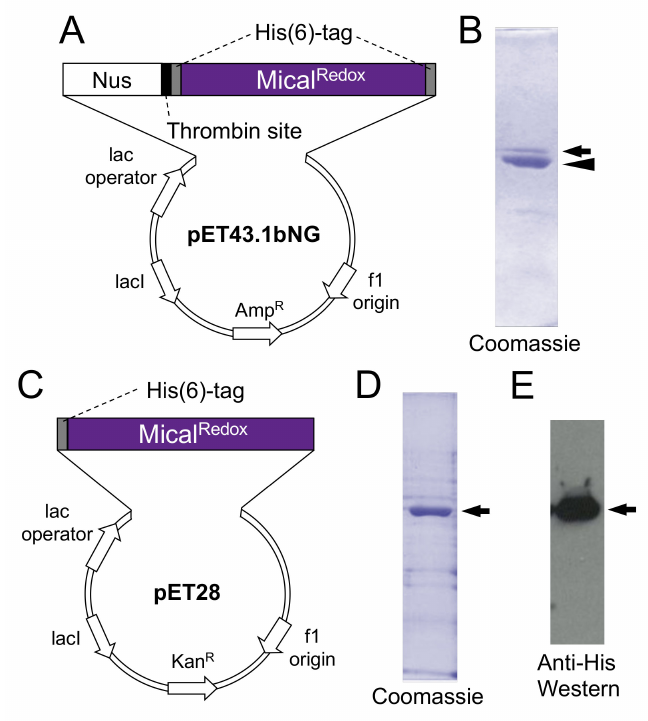
Figure 2. Expression and purification of Mical Redox protein with different fusion partners and chaperonins. ( A , B ) Nus solubility tag and low-temperature chaperonins only allow expression and solubility of small amounts of the Redox only portion of Mical. ( A ) Vector (pET43.1bNG) and insert for expressing a Nus solubility tag fused to Mical Redox protein. ( B ) Following thrombin digestion to remove the Nus solubility tag, the expected 1:1 ratio of Nus:Mical Redox protein is affected. In particular, while the Nus tag remains soluble (arrowhead), little Mical Redox protein remains in the soluble fraction (arrow). ( C – E ) Low-temperature chaperonins in combination with no solubility tags allow high expression and solubility of the Redox only portion of Mical. ( C ) Vector (pET28) and insert for expressing Mical Redox protein without a solubility tag. ( D , E ) High levels of Mical Redox protein is expressed and is soluble (arrows) with this expression strategy, as can be seen by Coomassie staining ( D ) and His antibody Western analysis ( E